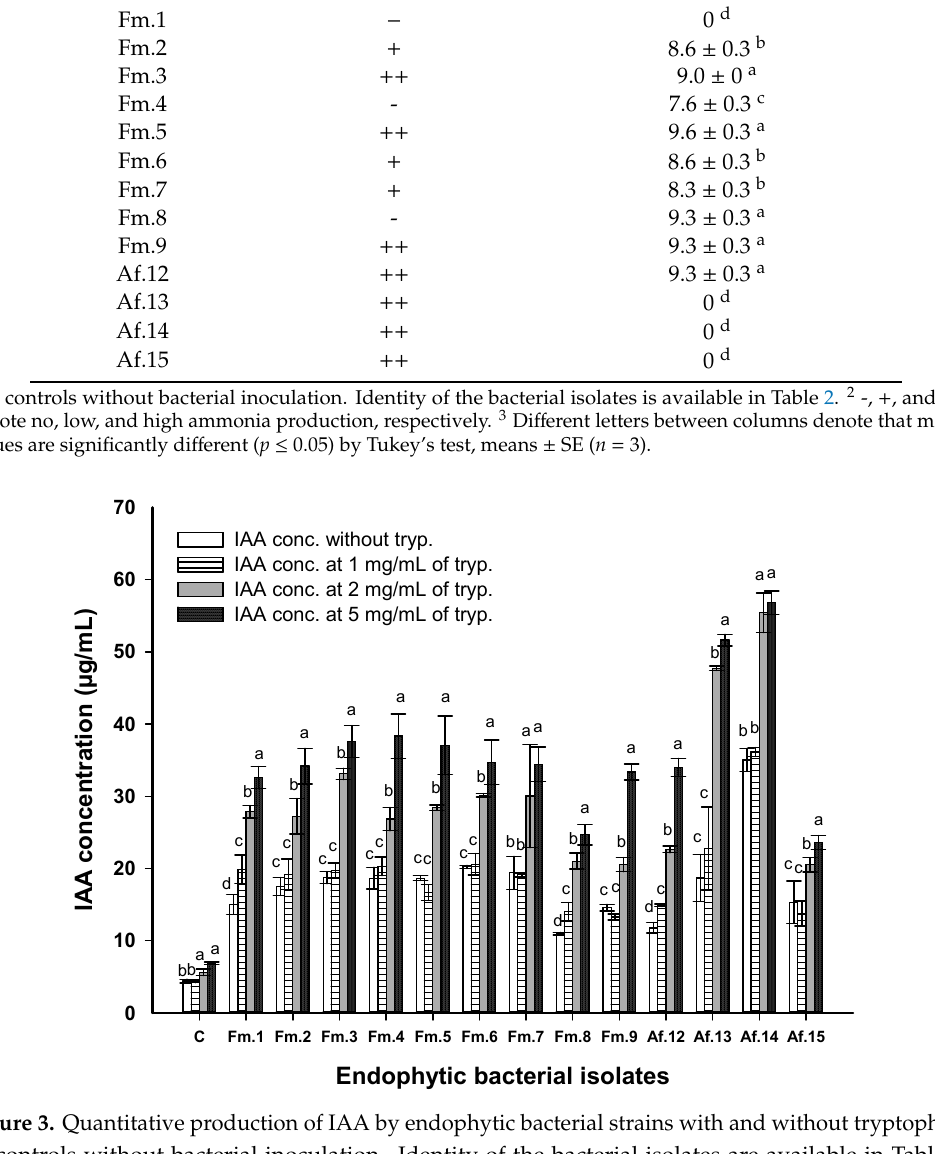
Figure 3. Quantitative production of IAA by endophytic bacterial strains with and without tryptophan. C, controls without bacterial inoculation. Identity of the bacterial isolates are available in Table 2. Data are statistically different at p ≤ 0.05 by Tukey's test, ( n = 3); error bars are means ± SE. Bars with the same letter for each endophytic isolate did not differ significantly, different letters on bars denote that mean values are significantly different at significant level of (P ≤ 0.05), error bars are means ± SE.